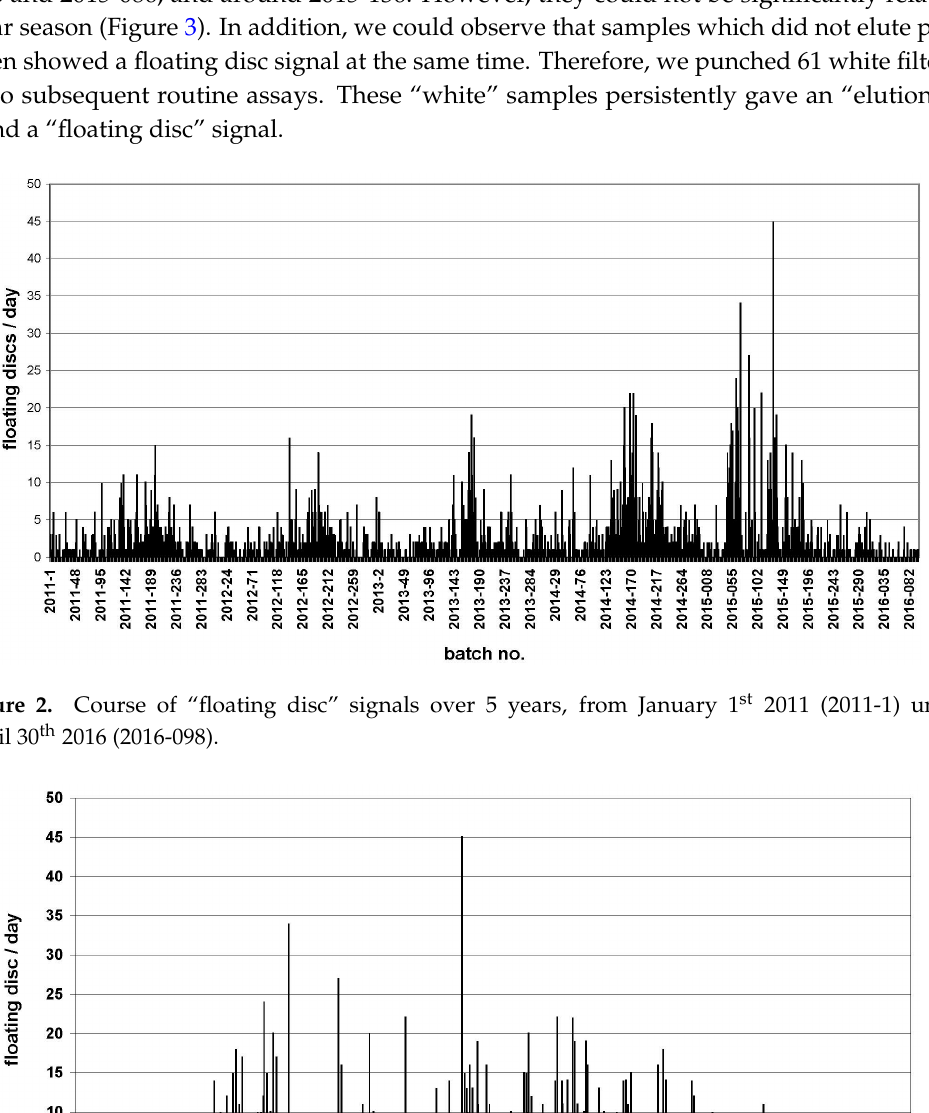
Figure 1. Utilization ratio of both Genetic Screening Processors (GSPs) over 5 years; ( ▪ ) = ratio of total number of measurements; ( ♦ ) ratio of “floating disc” signals.